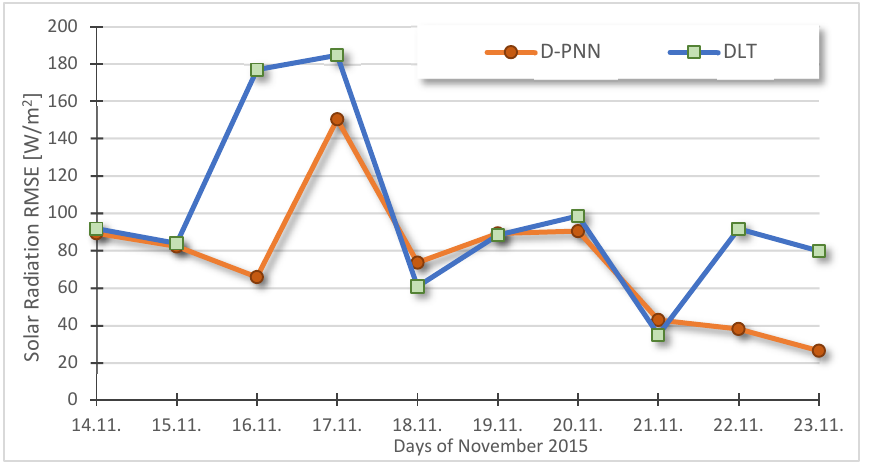
Figure 8. 10-day solar radiation avg. day prediction RMSE: DNN = 74.74, DLT = 99.04 [W/m 2 ].